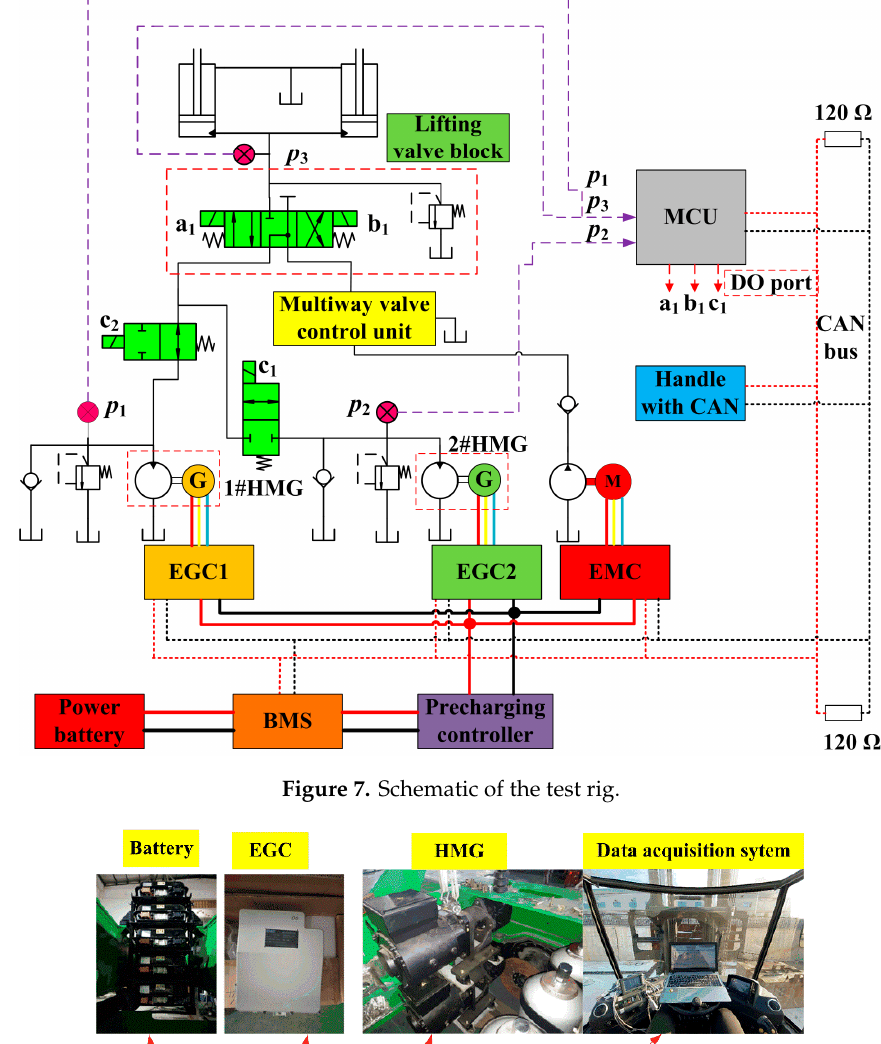
Figure 7. Schematic of the test rig.